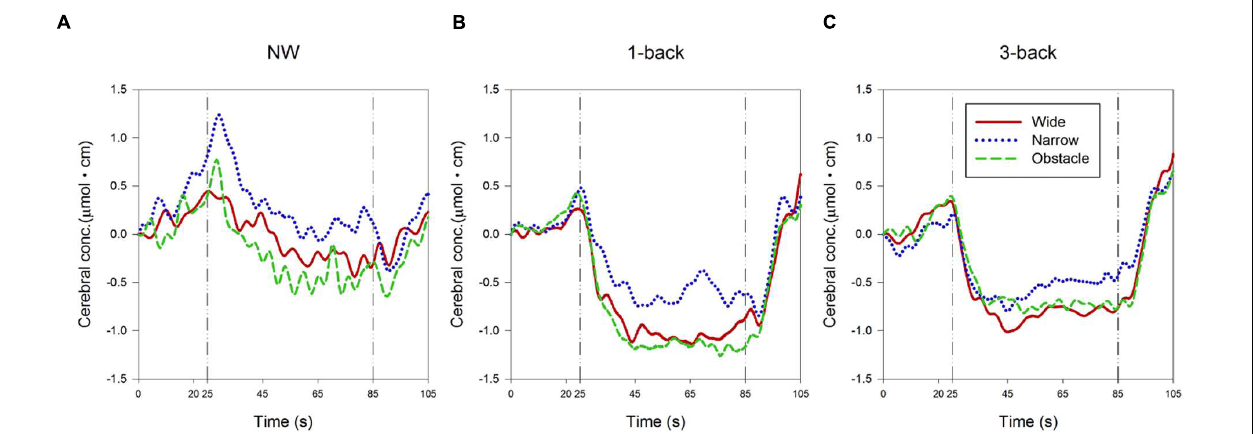
FIGURE 4 | Presentation of changes in the relative concentration level of HbO during (A) normal walking, (B) dual-tasking with the 1-back task, and (C) dual-tasking with the 3-back task from pre-test quiet standing (0–20 s), countdown block (20–25 s), test block (25–85 s), and post-test quiet standing (85–105 s). Graphs are showed as ensemble-averaged waveforms from 24 participants for different combinations of cognitive task complexity and walking road